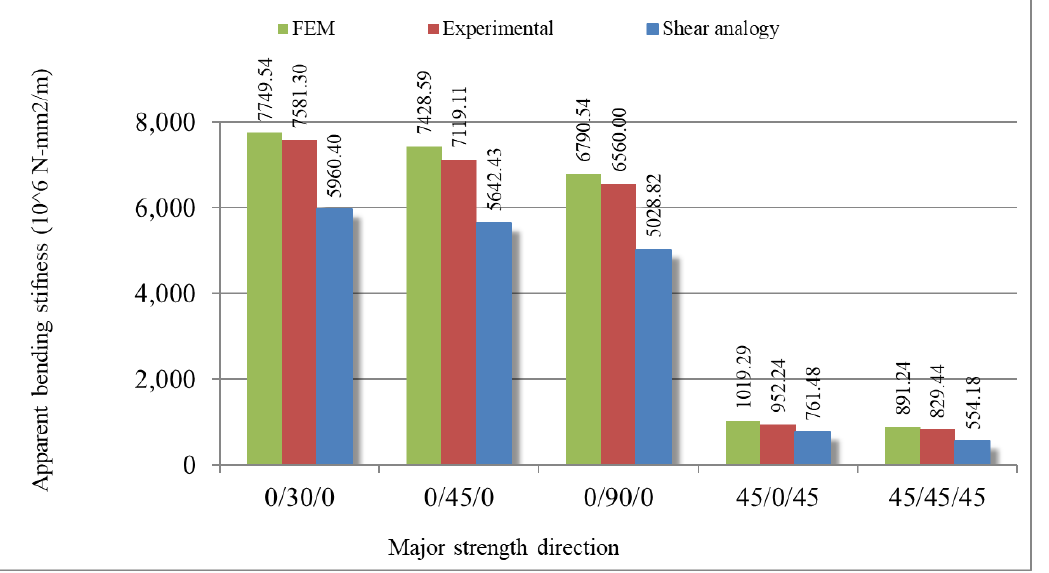
Figure 10. Comparison of apparent bending stiffness (EI app ) values estimated by the experimental test, shear analogy, and FEM methods in major axis of